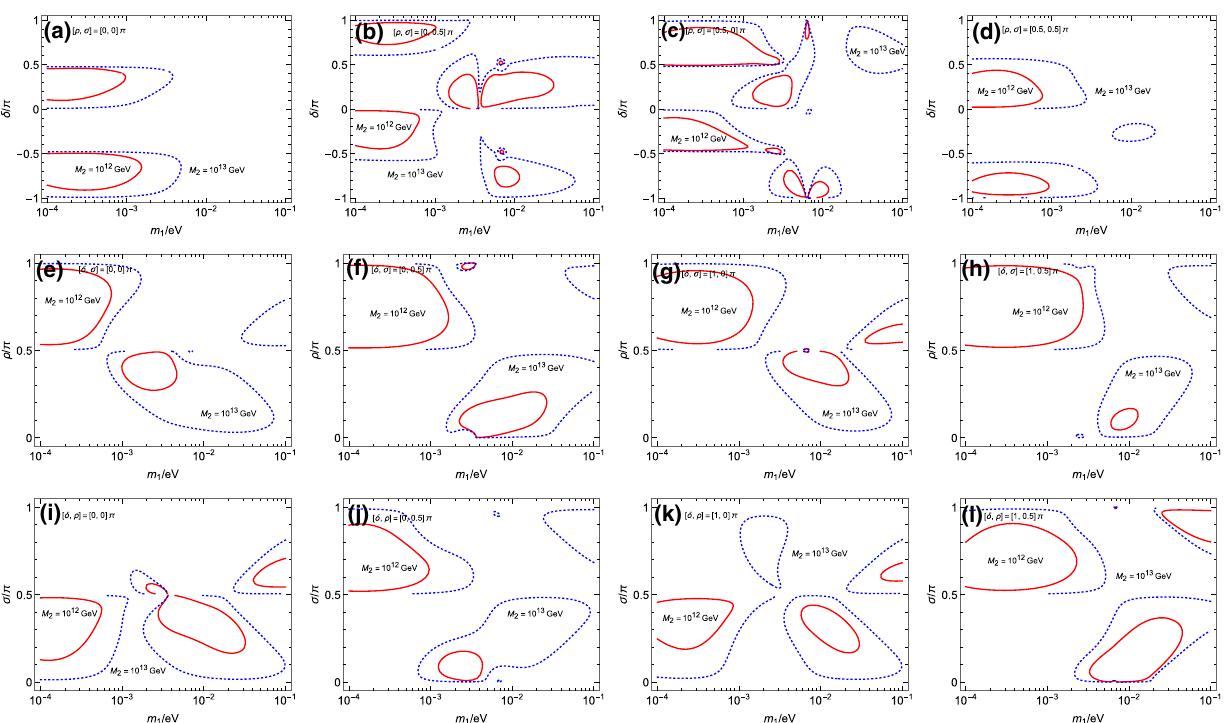
Fig. 3 First row: in the scenario of M D being the triangluar matrix and NO case, for the various trivial-value combinations of [ ρ,σ ] and some benchmark values of M 2 (see the labels for the plotted lines), the values